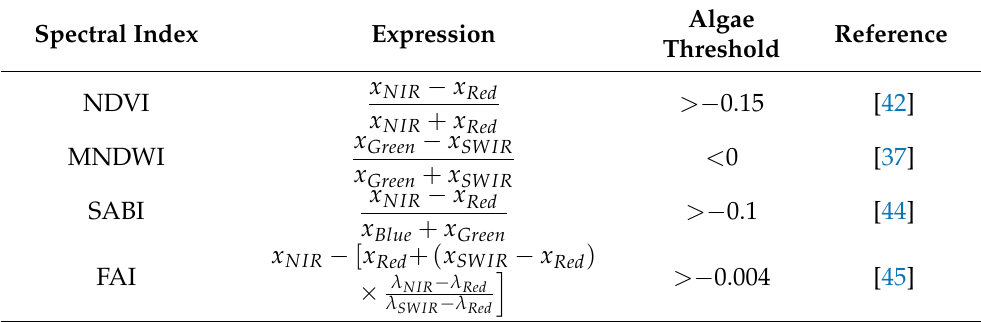
Table 1. Summary of spectral indices and thresholds used for algal bloom detection. Spectral Index Expression